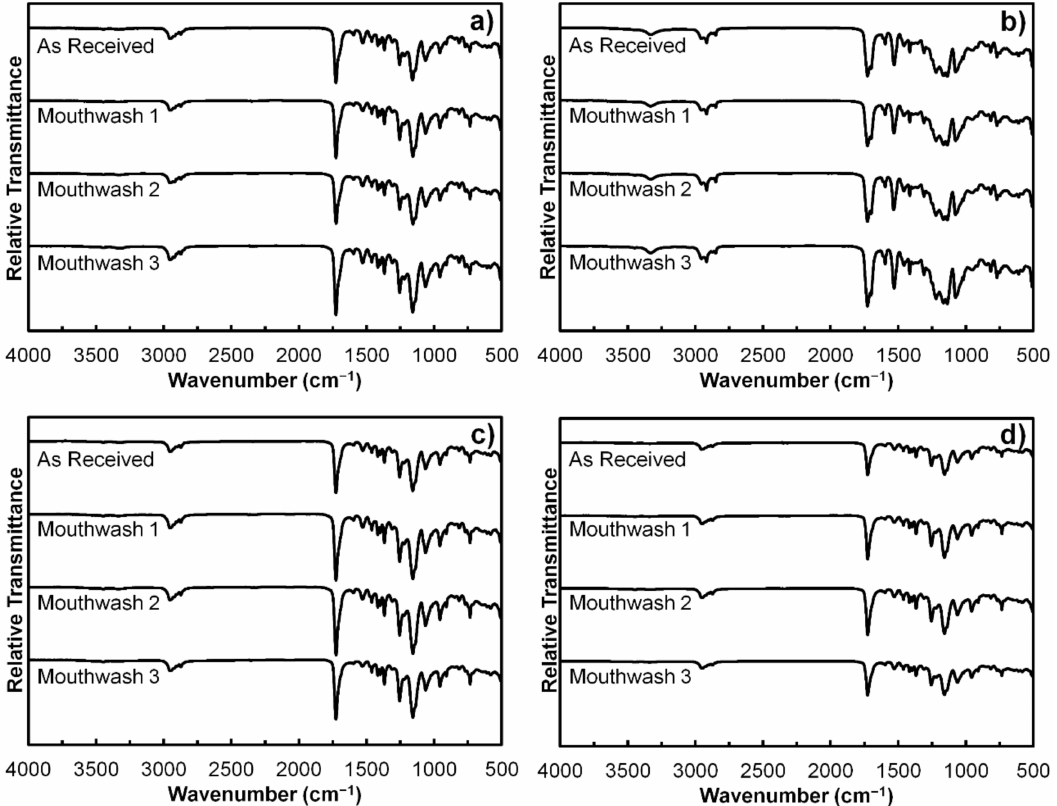
Figure 5. The FTIR spectra of the as-received and mouthwash-rinsed samples: ( a ) Brand A; ( b ) Brand B; ( c ) Brand C; and ( d ) Brand